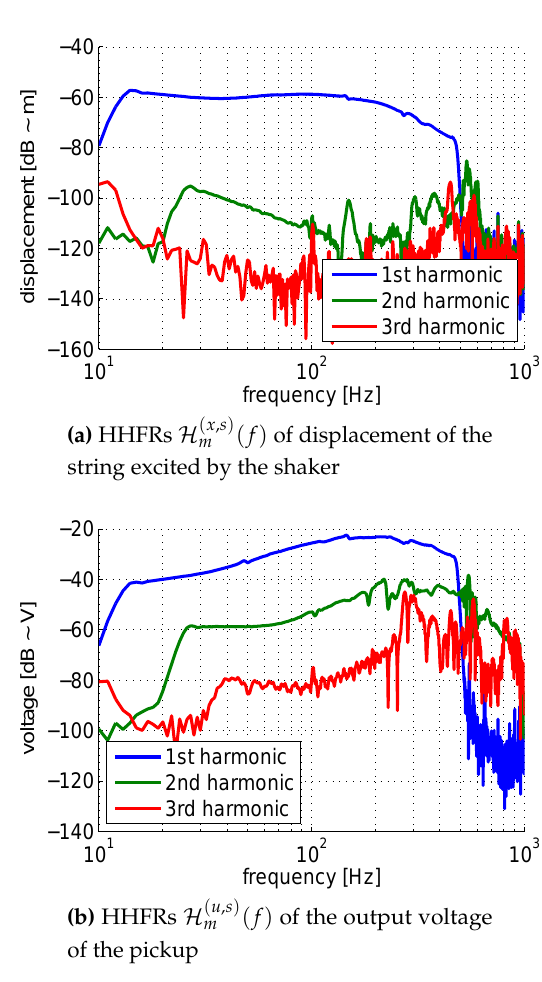
Figure 4. First three Higher Harmonic Frequency Responses (HHFRs) of ( a ) displacement of the string excited by the shaker and ( b ) the output voltage of the pickup.